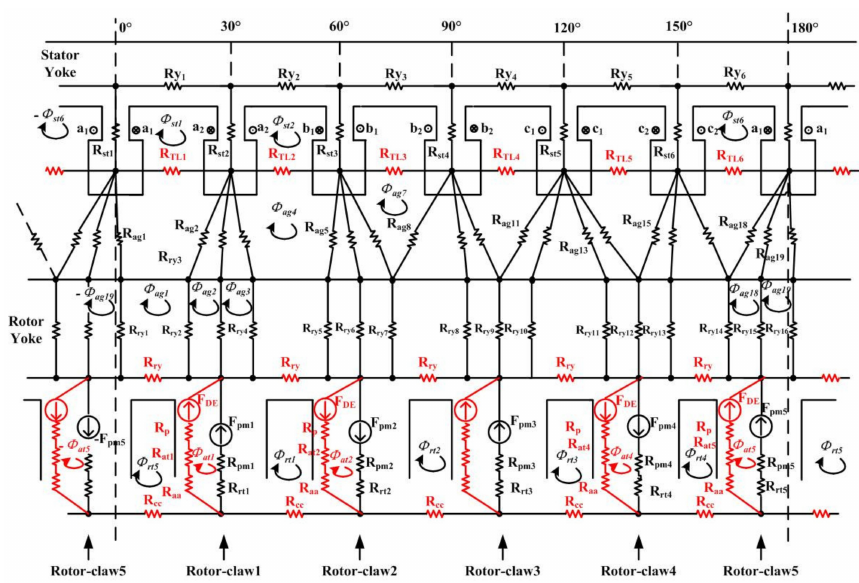
Figure 8. MEC network for HECPG ( θ r = 35 ◦